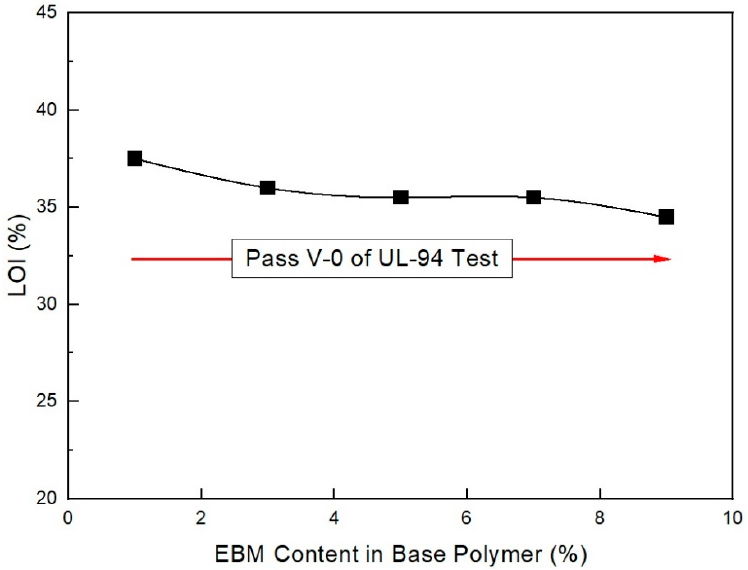
Figure 13. LOI (%) of EVA/EXACT 8201/CLNA ‐ 8400/. 125 phr flame ‐ retardant (MH+ZB+RP) formulations as a function of EBM content.